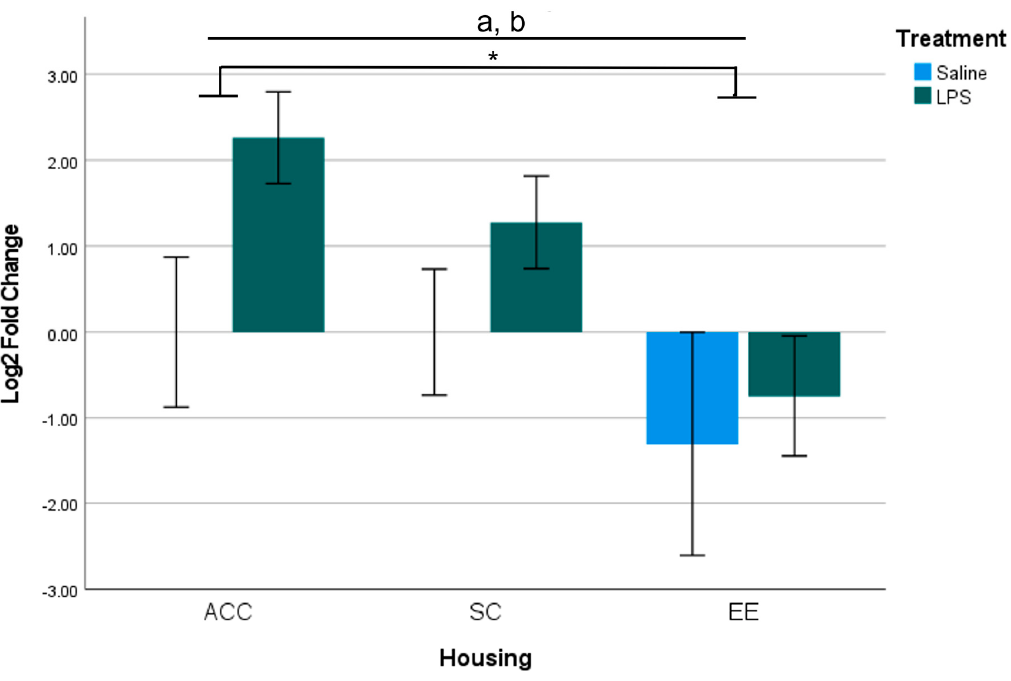
Figure 1. B2 SINE expression for Standard, Social Control, and Enriched housing conditions in the mPFC. Standard (Saline: n = 12, LPS: n = 10), Enriched (Saline: n = 12, LPS: n = 14), Social Control (Saline: n = 13, LPS: n = 15). A two-way ANOVA revealed simple main effects from housing and treatment. There were no statistically significant interactions. Post-hoc testing revealed a statistically significant difference between the enriched environment (EE) and the Standard Control (ACC). (* p ≤ 0.05, a p < 0.05, main effect of treatment, b p < 0.05, main effect of housing; mean ± SEM). The dorsal striatum (DST) was examined as it is also highly stress-sensitive [79]. In the DST, there was no treatment by housing interaction e ff ect (F (2,75) = 0.760, p = 0.472), no e ff ect of treatment (F (1,75) = 0.734, p = 0.394), and no e ff ect of housing (F (2,75) = 0.687, p = 0.506) (Figure 2).